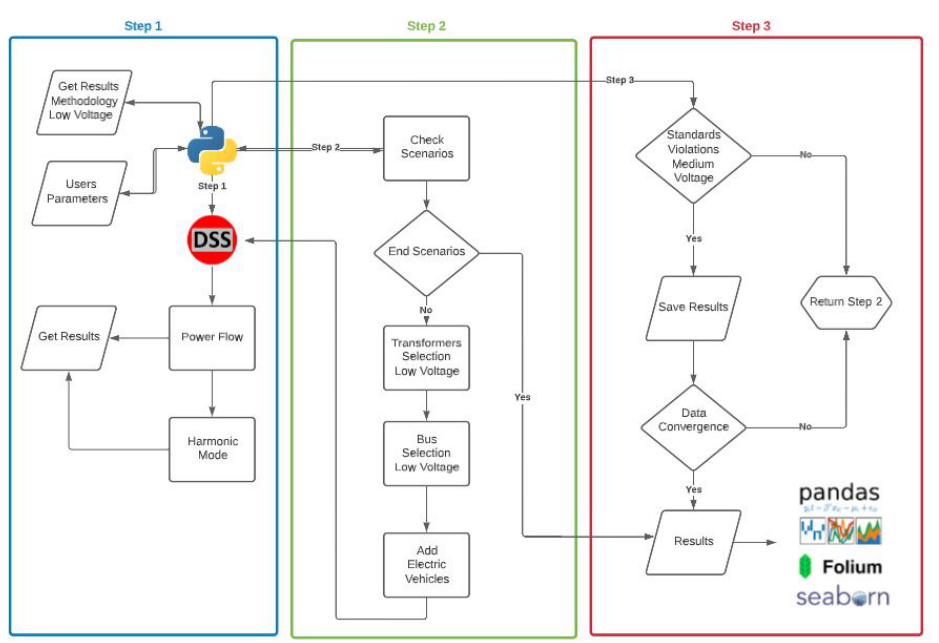
Figure 3. Medium-voltage methodology